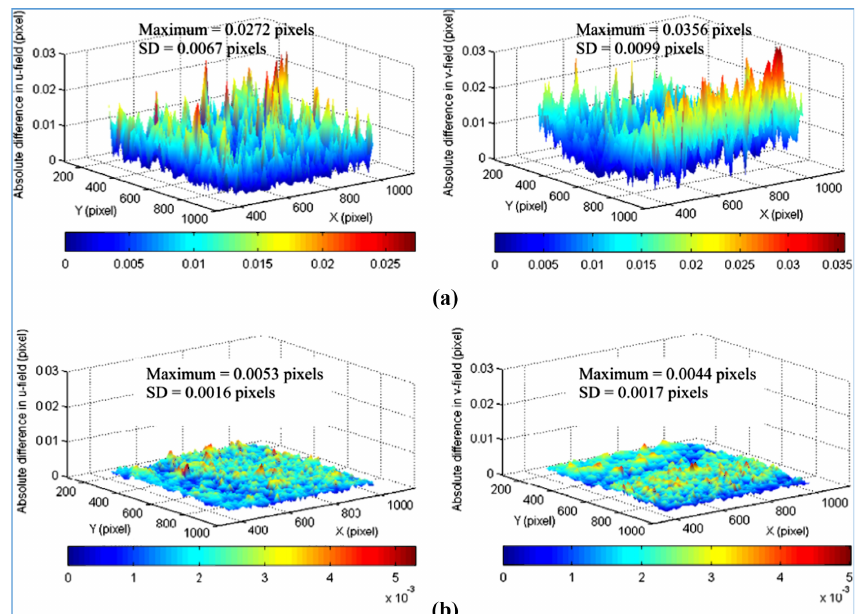
Figure 5. (a) Absolute difference in u -displacement (left) and v -displacement (right) fields measured by NR algorithm using quintic B-spline interpolation without Gaussian pre-filtering and quintic B-spline interpolation with Gaussian pre-filtering and (b) absolute difference in u - displacement (left) and v -displacement (right) measured by NR algorithm using bicubic interpolation with Gaussian pre- filtering and quintic B- spline interpolation with Gaussian pre- filtering (Pan,